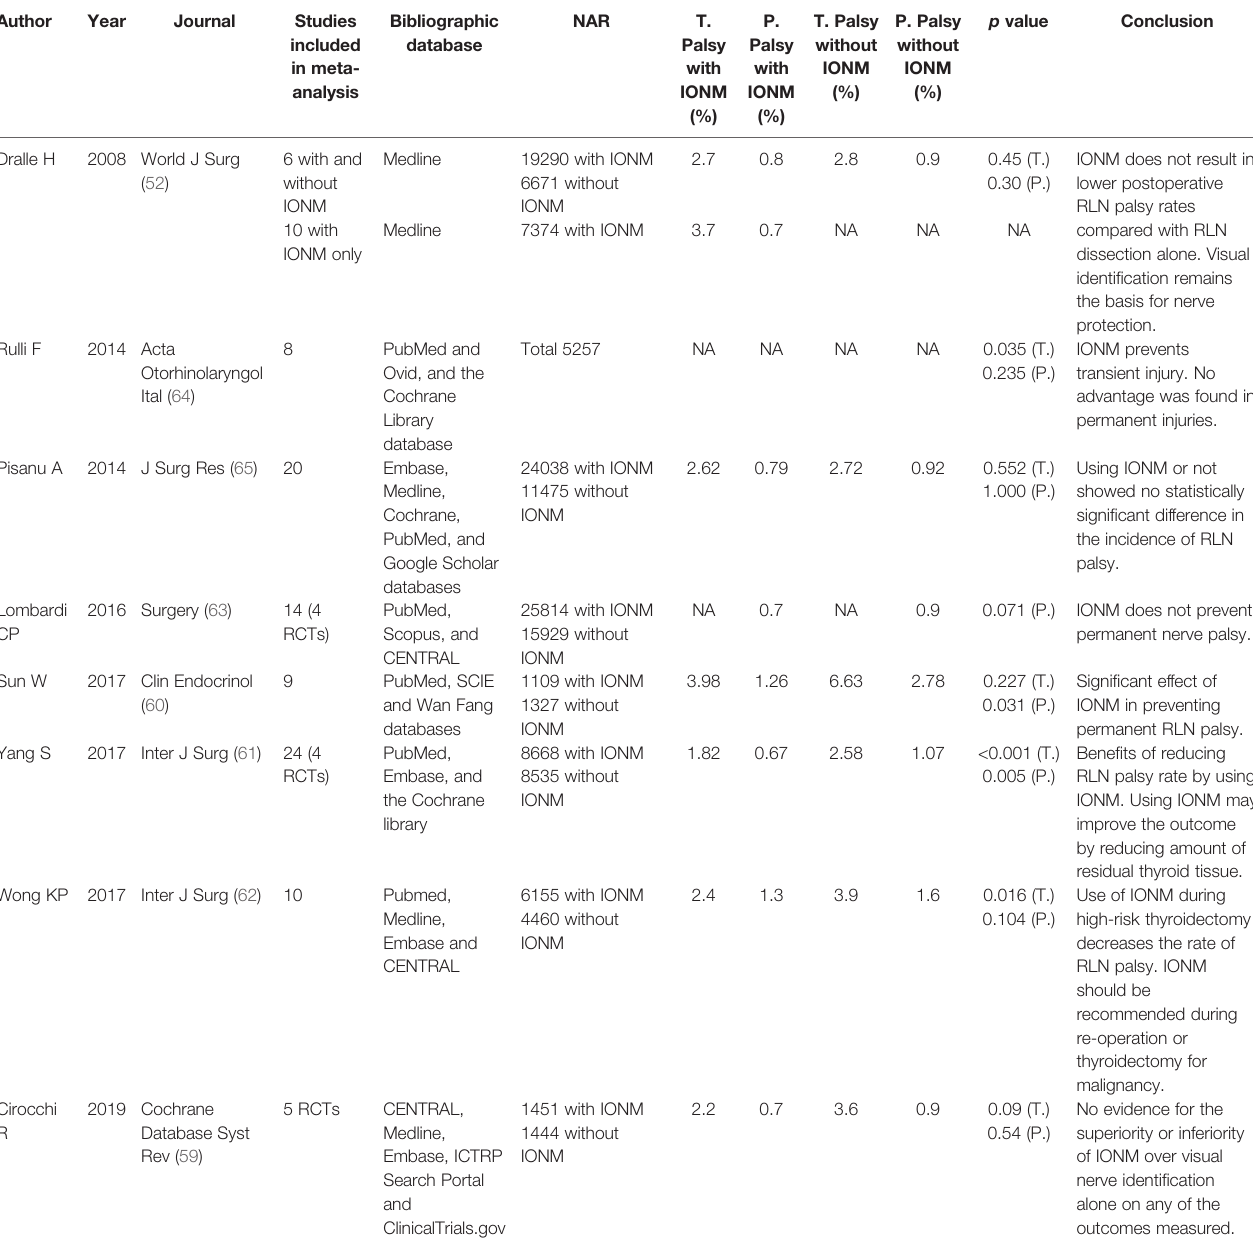
TABLE 1 | Summary of meta-analysis articles on the topic of RLN palsy after thyroid surgery with and without use of